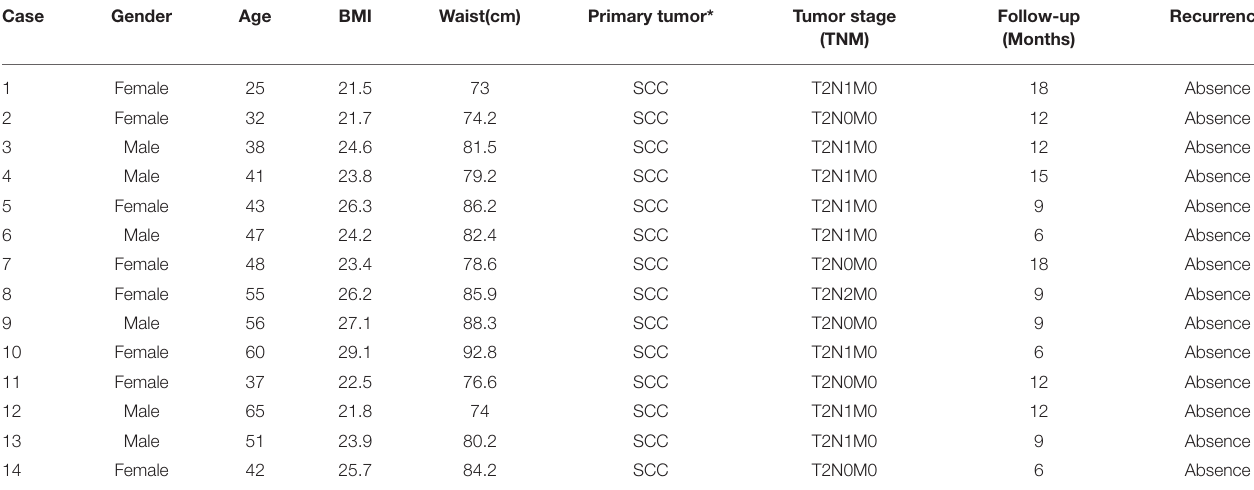
TABLE 1 | Patient characteristics.